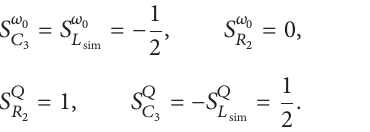
𝑍 4 is taken as